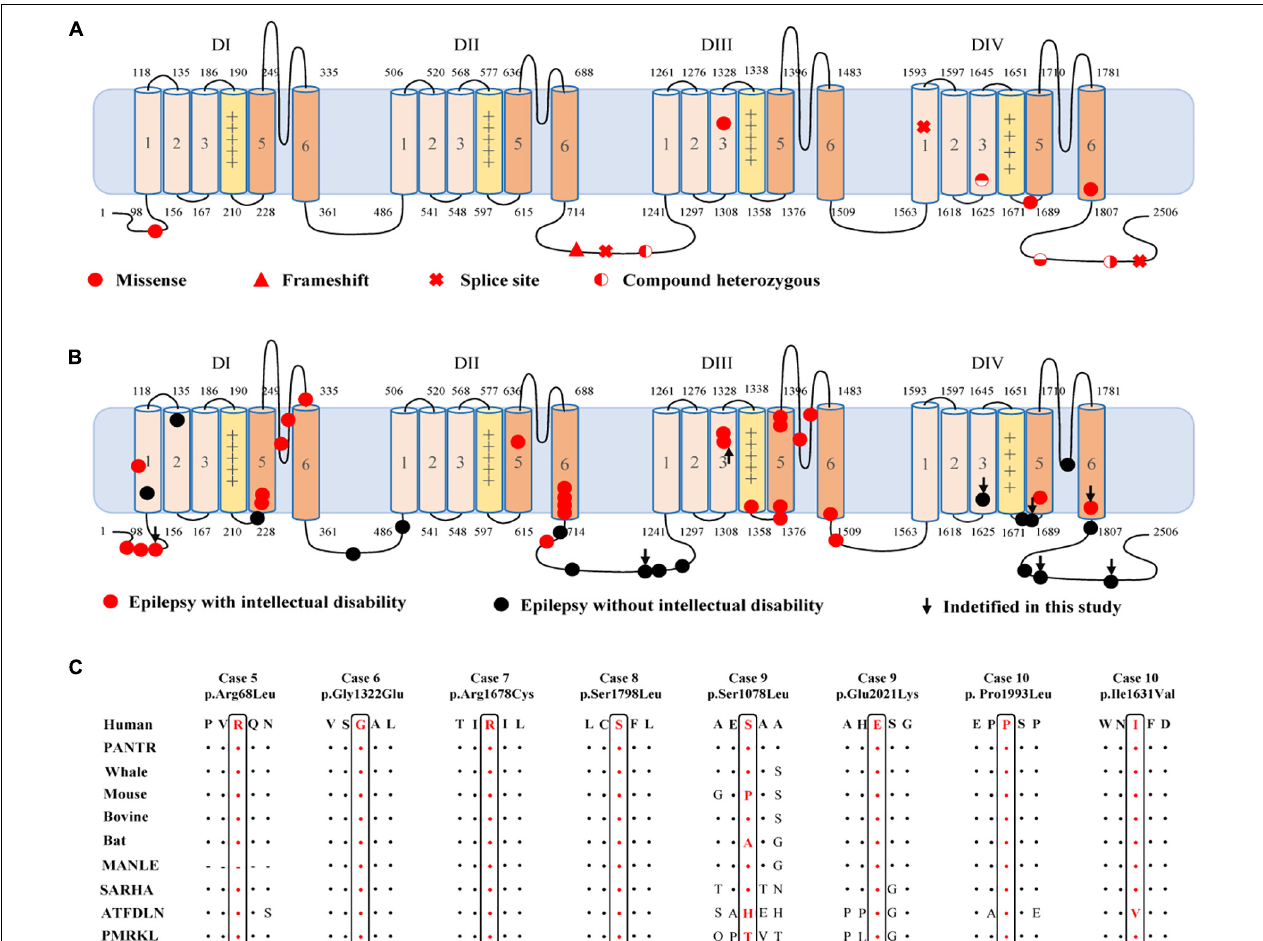
FIGURE 2 | Location of the identified CACNA1A mutations in Cav2.1 and amino acid sequence alignment of the missense mutations. (A) Schematic illustration of the Cav2.1 protein and the location of the CACNA1A mutations identified in this study. (B) Schematic illustration of the Cav2.1 protein and the location of the epilepsy-related CACNA1A missense mutations. (C) Amino acid sequence alignment of the eight missense mutations with protein substitutions show that Arg68, Gly1322, Arg1678, Ser1798, Pro1993, and Glu2021 are highly conserved across species. Ser1078 and Ile1631 show a low degree of conservation.